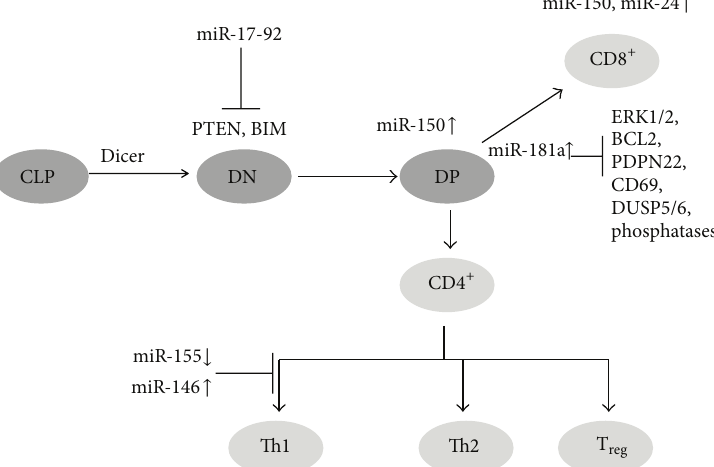
Figure 8: miRNA in T cell development. miRNA regulation at different developmental stages of T-cell development (CLP-common lymphoid progenitor, DN-double negative, DP-bouble